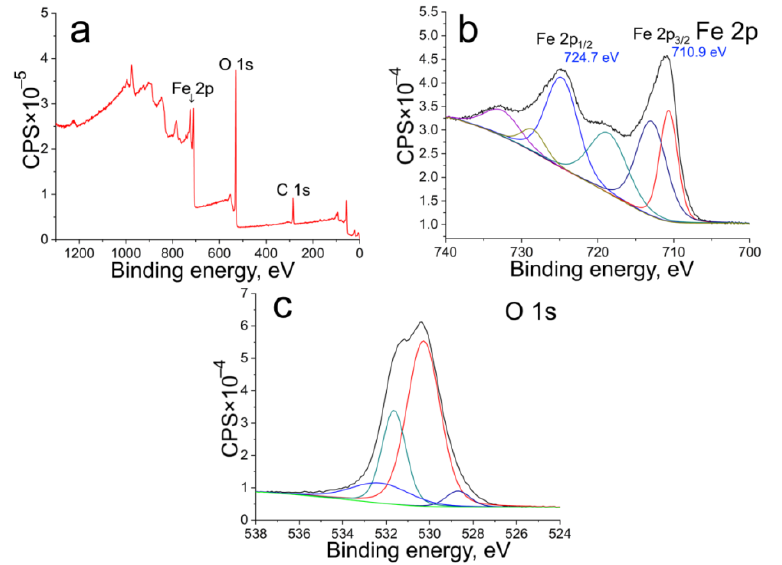
Figure 4. Survey ( a ), Fe 2p ( b ), and O 1s ( c ) XPS spectra of ANPs obtained during 12 h synthesis. Table 2. Position of Fe 2p peaks and Fe/O ratio in the samples at different time of synthesis. Time, h